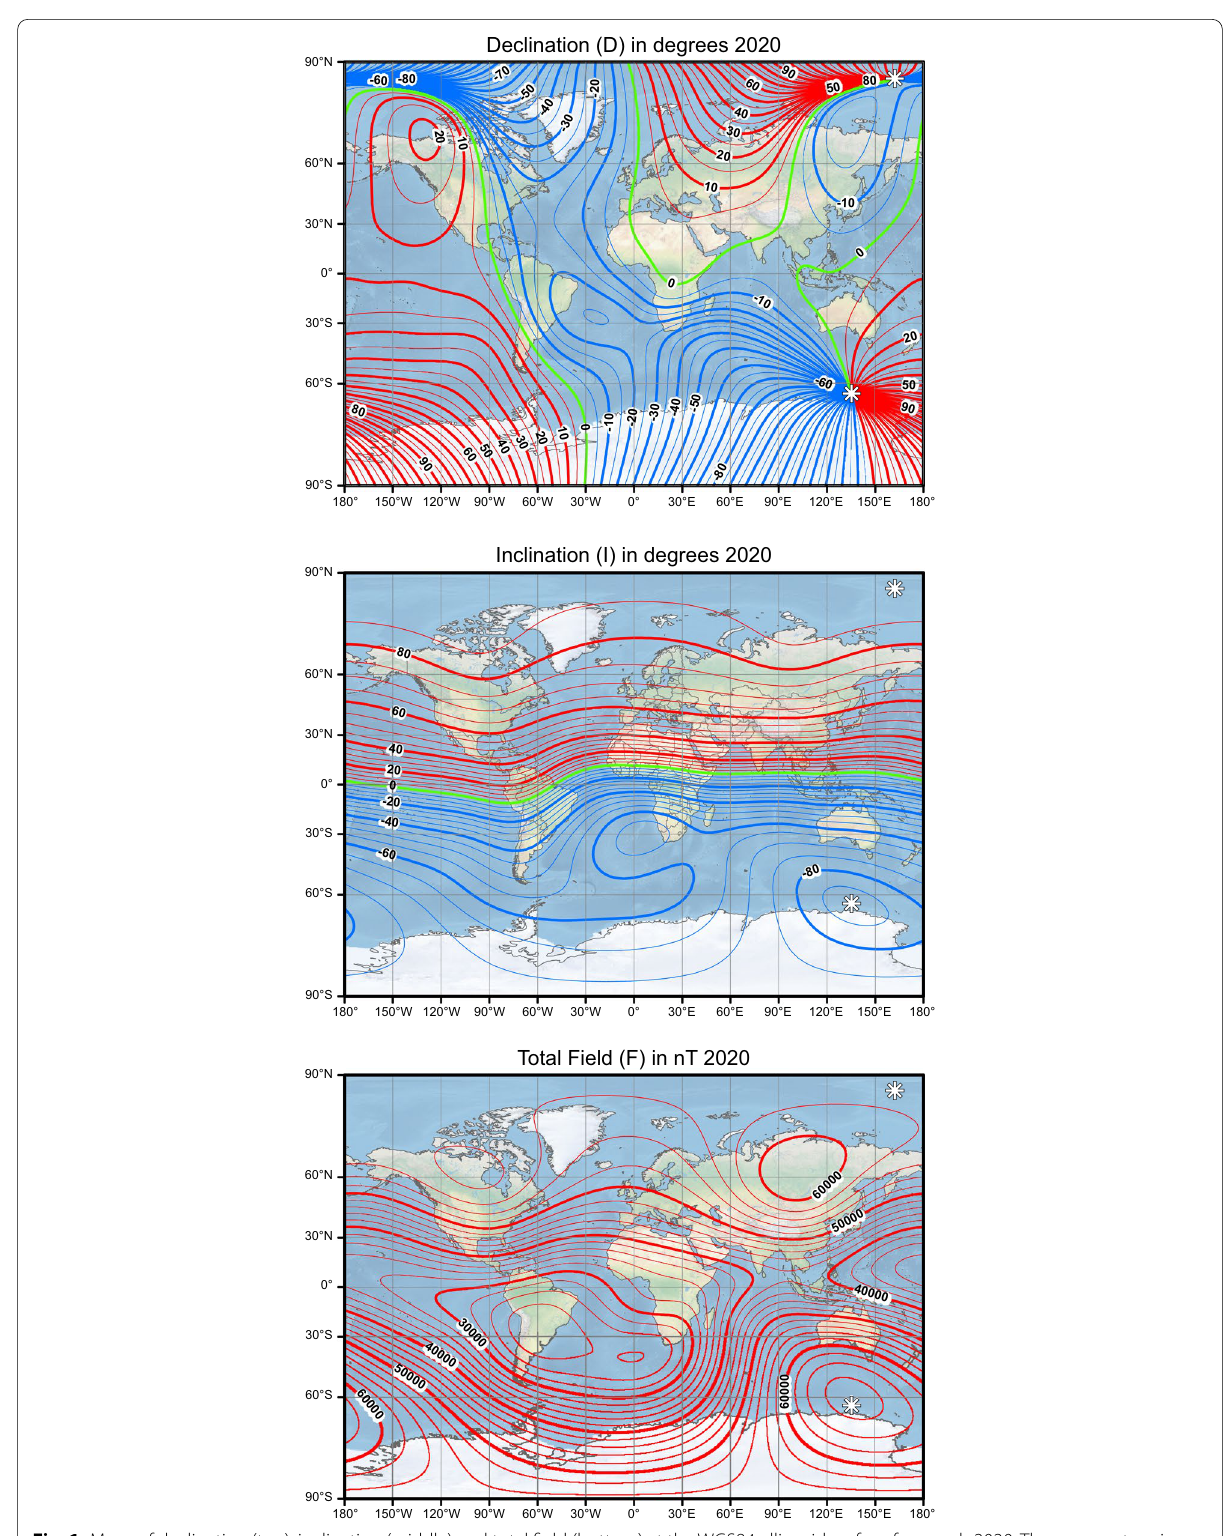
Fig. 1 Maps of declination (top), inclination (middle) and total field (bottom) at the WGS84 ellipsoid surface for epoch 2020. The zero contour is shown in green, positive contours in red, and negative contours in blue. White asterisks indicate locations of the magnetic dip poles. Projection is Miller